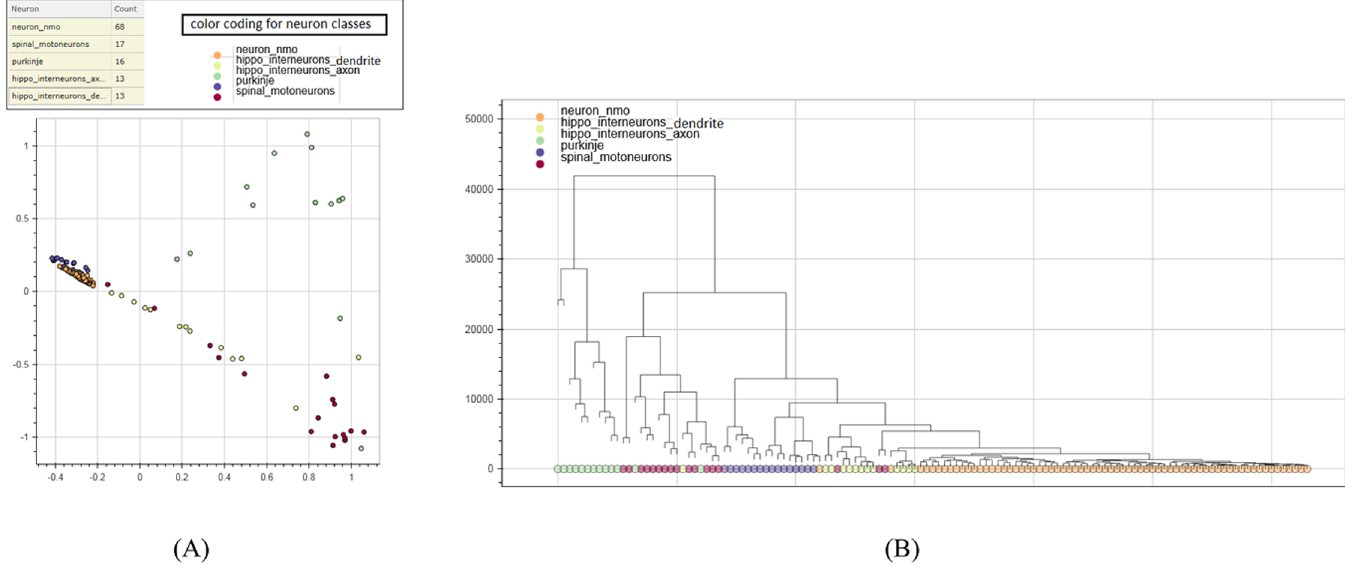
Fig 8. Illustration for Dataset 2. (A) Embedding of Dataset2 in 2D via Laplacian Eigenmap.Each dot represents a neuron,and its color corresponds to its type. Its hierarchical clustering tree (HCT) is shown in (B), where each leaf correspondsto a neuron.